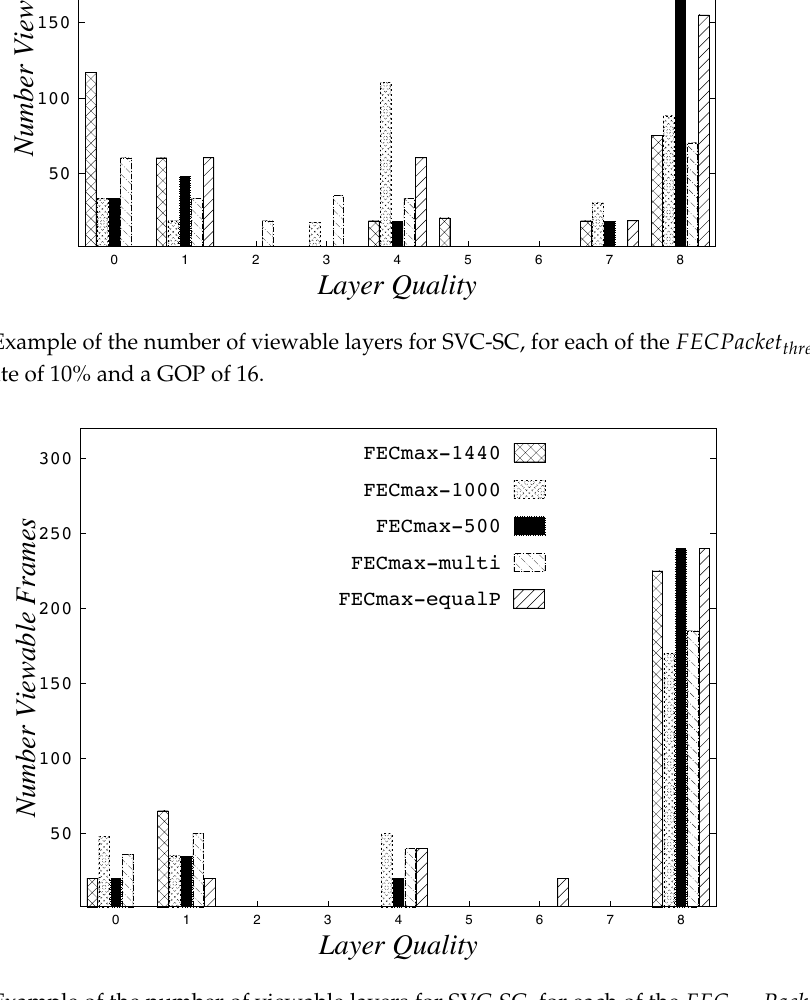
Figure A17. Example of the number of viewable layers for SVC-SC, for each of the FEC max Packet thres , at a packet loss rate of 10% and a GOP of